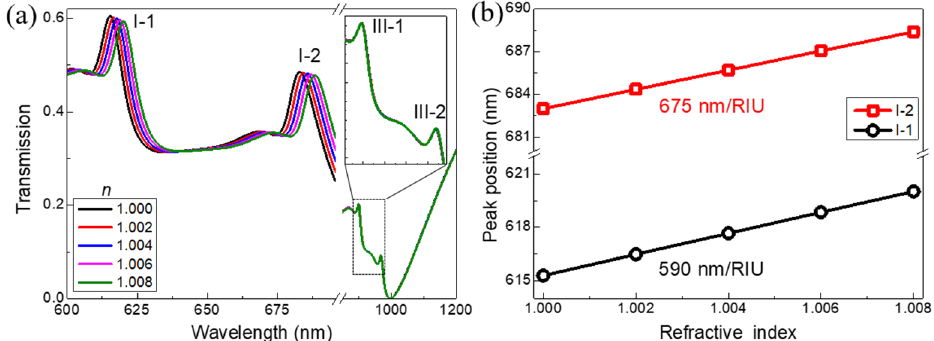
Figure 5. ( a ) The calculated transmission spectra of the designed 3D metamaterials with inclined incidence angle ( θ ) being 3° immersed in surrounding medium varied from 1.000 to 1.008. ( b ) The dependence of the positions of two peaks (I-1 and I-2) as a function of refractive index. The positions of the two transmission peaks (I-1 and I-2) as a function of the RI of the two narrow two transmission peaks I-1 and I-2 were found to be 590 nm/RIU and 675 nm/RIU, respectively. The FoM values were 104 for transmission peak I-1 and 85 for the